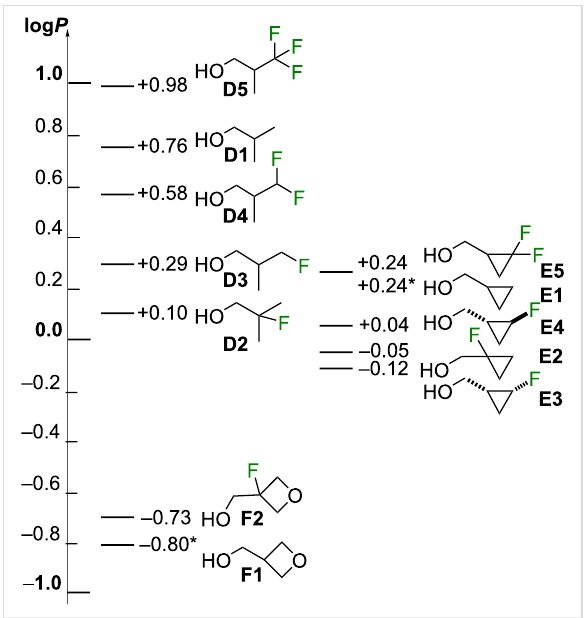
Figure 5: Distribution of the experimental lipophilicity values of series D , E and F (* denotes an estimated value, see Supporting Information File